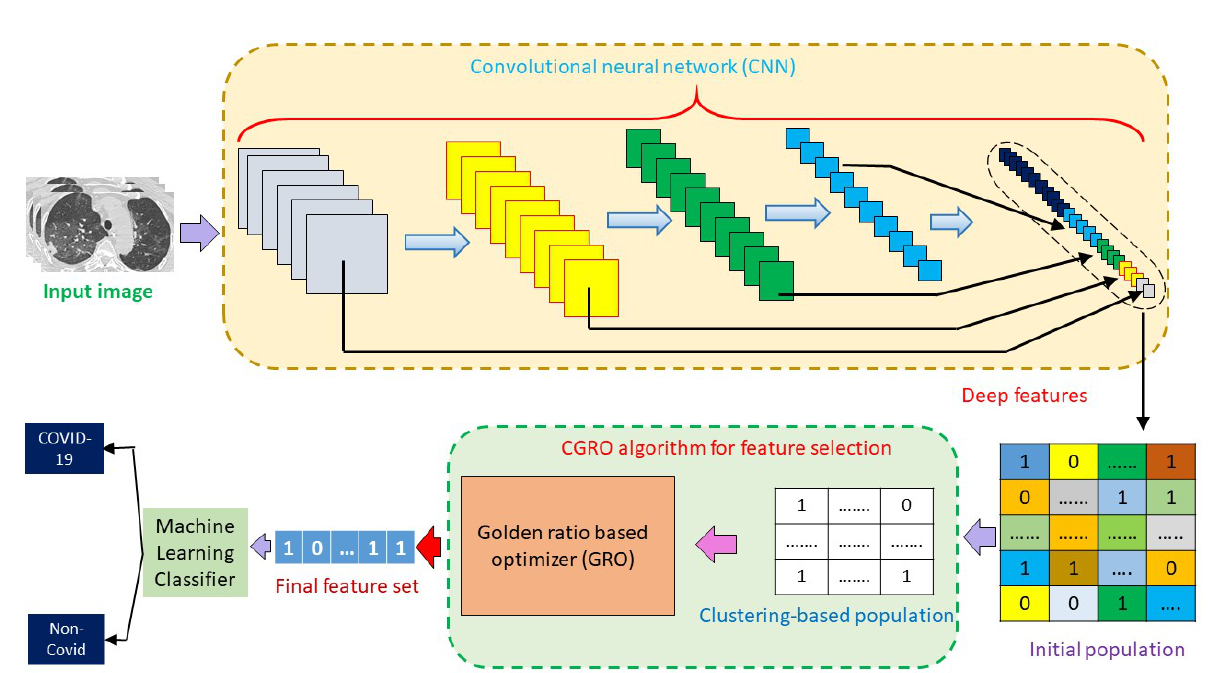
Figure 3. Workflow of the proposed Cluster-based Golden Ratio based Optimizer (CGRO) based feature selection approach for COVID-19